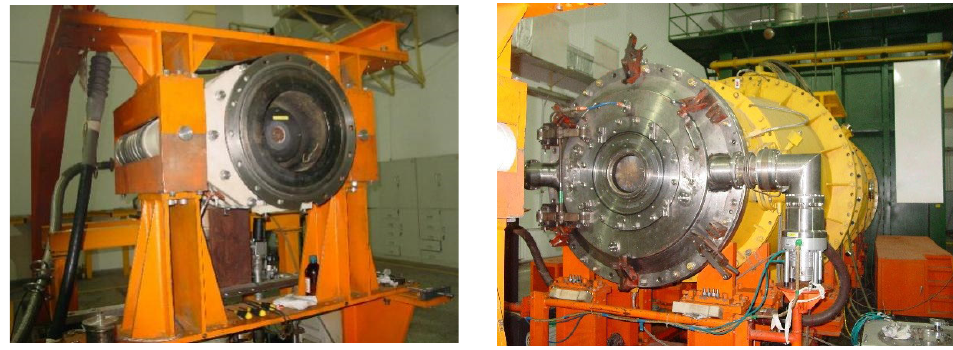
Figure 1. Pictures of the REB device.